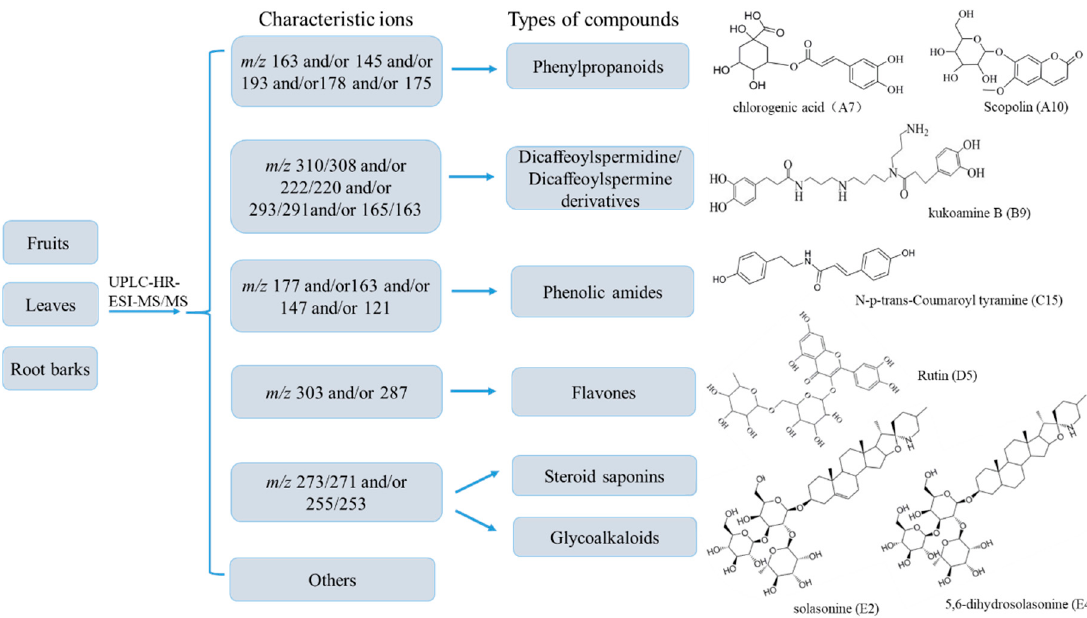
Figure 2. A diagram for rapid classification and tentative identification of chemical constituents in the extracts of fruits, leaves and root barks of L. barbarum by UPLC-HR-MS, and the structures of standard compounds in different classes.